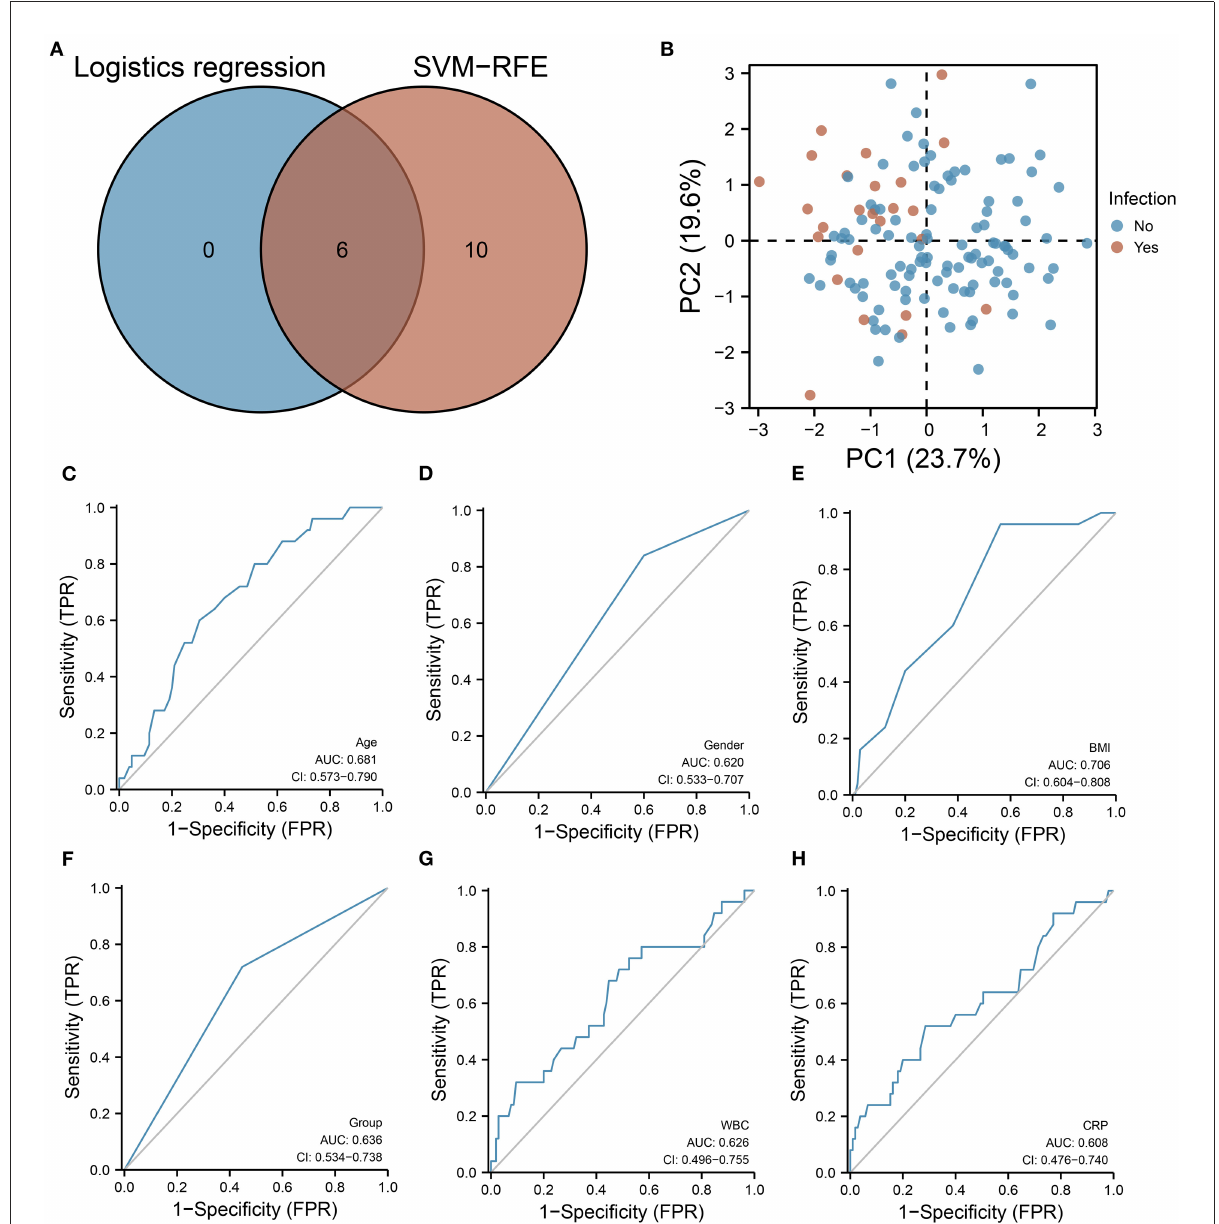
FIGURE2 SVM-RFE as well as logistic regression models are used for screening important clinical features. (A) Venn diagram showing six features associated with infection prediction. (B) PCA showing that based on these six characteristics, a better distinction can be made between infected and uninfected patients. (C – H) ROC curves showing the predictive performance of (C) age, (D) biological sex, (E) BMI, (F) hydromorphone concentration grouping, (G) WBC, and (H) CRP on